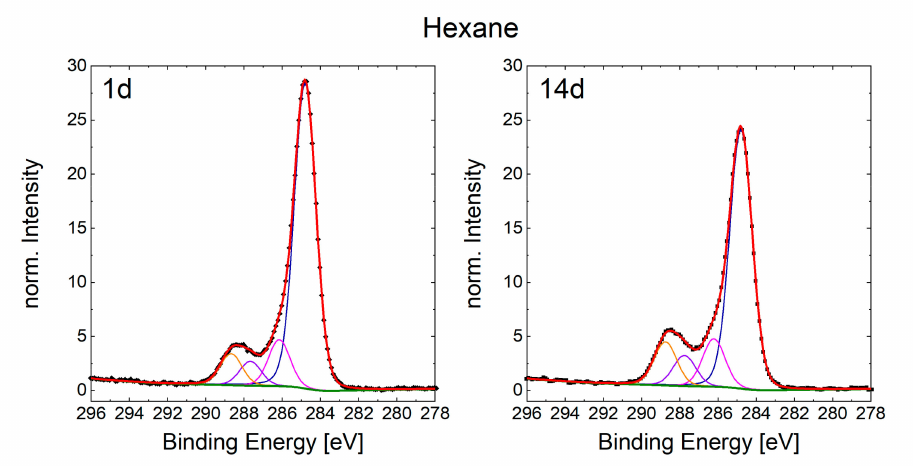
Figure A5. C 1s spectra of structured sample 1 and 14 days after cleaning with hexan.